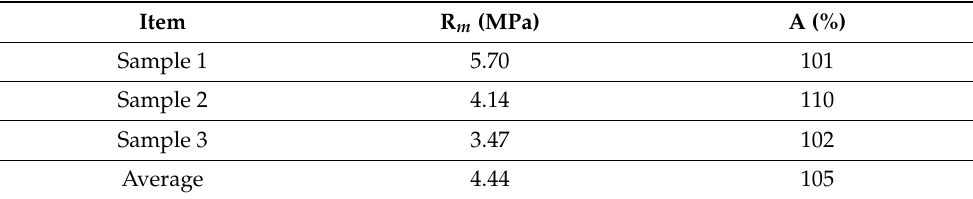
Figure 9. Tensile curves of samples made from the test plate. Table 5. Mechanical properties, established on the basis of the tensile